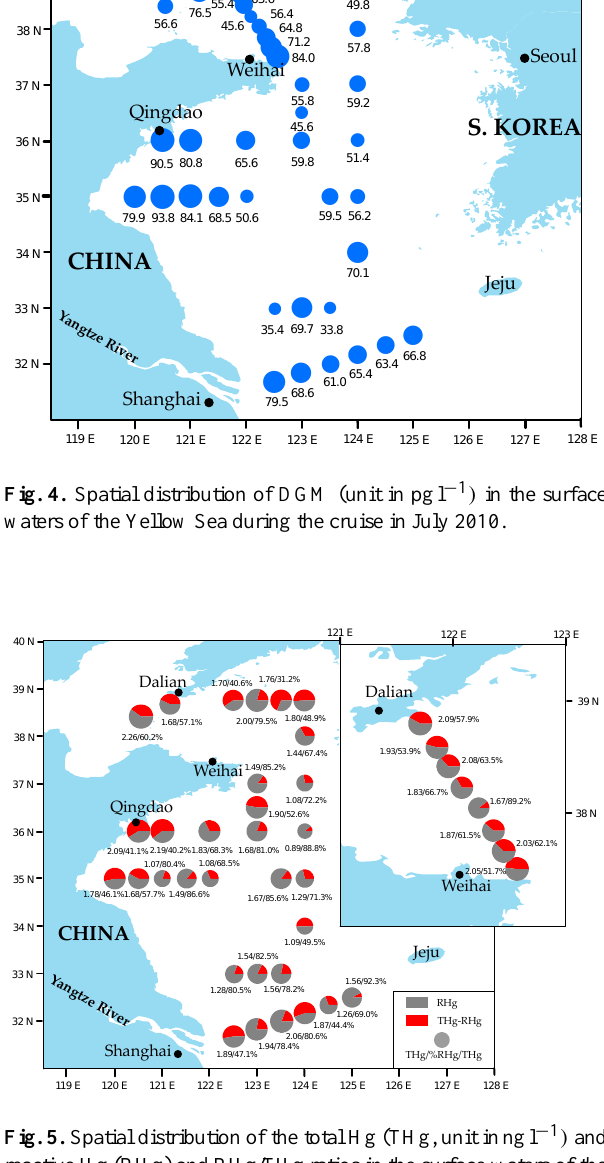
Fig. 5. Spatial distribution of the total Hg (THg, unit inngl − 1 ) and reactive Hg (RHg) and RHg/THg ratios in the surface waters of the Figure 5. Spatial distribution of the total Hg (THg, unit in ng l -1 ) and reactive Hg Yellow Sea during the cruise in July (RHg) and RHg/THg ratios in the surface waters of the Yellow Sea during the cruise in July 2010.